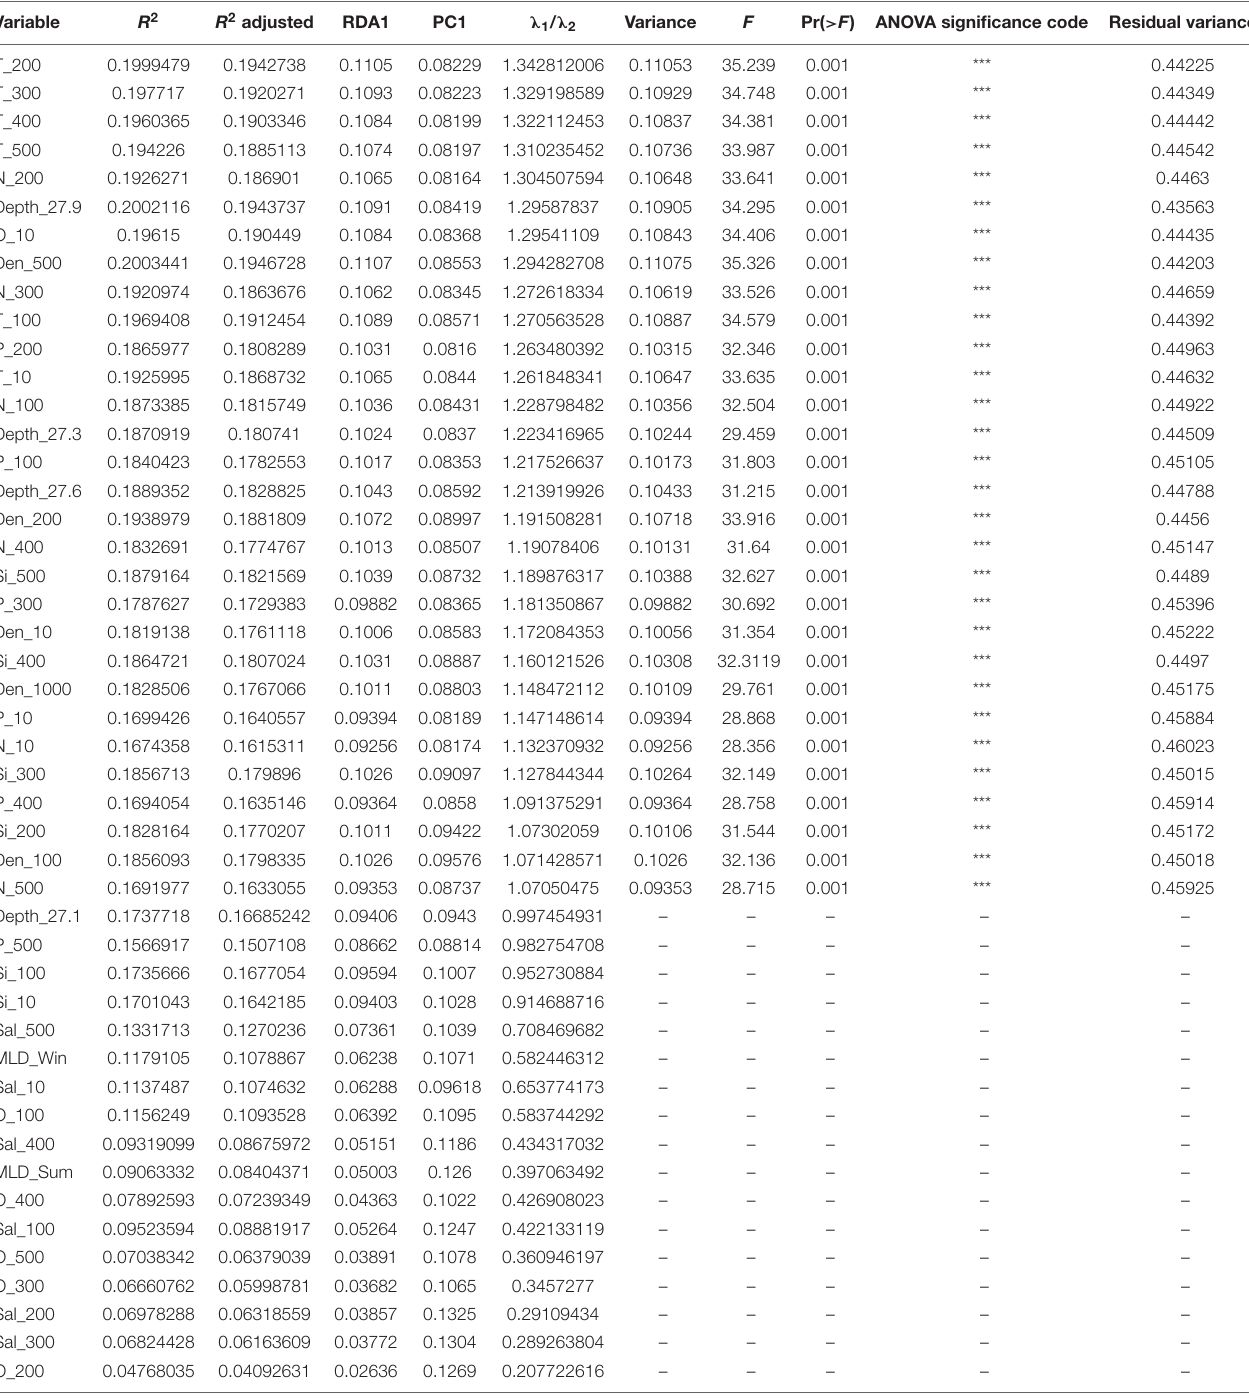
TABLE 2 | List of environmental variables used for individual redundancy analysis and Lambda ( λ 1 / λ 2 ) selection for partial redundancy